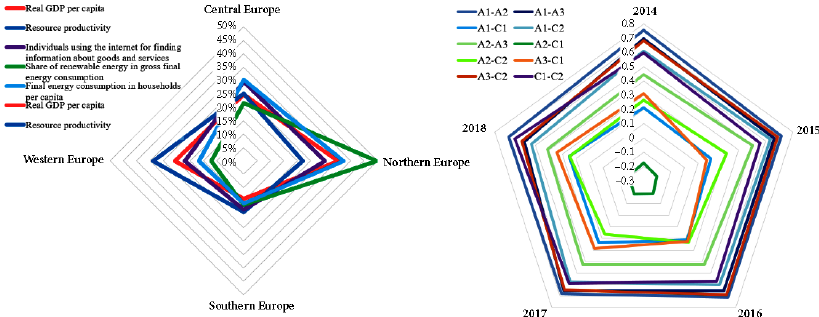
Figure 1. Regional A1, A2, A3, C1, and C2 share from the analysed European area. The evolution of the Pearson correlation coefficient (source: authors’